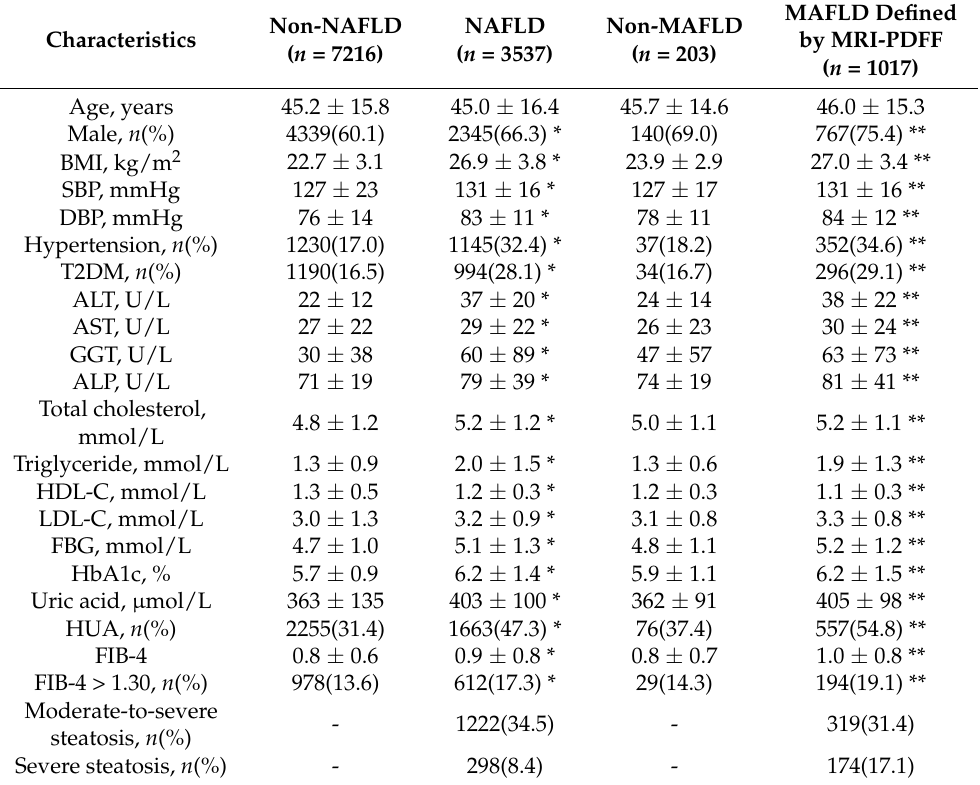
Table 1. Anthropometrical and metabolic characteristics of enrolled subjects with NAFLD and MAFLD, or those with